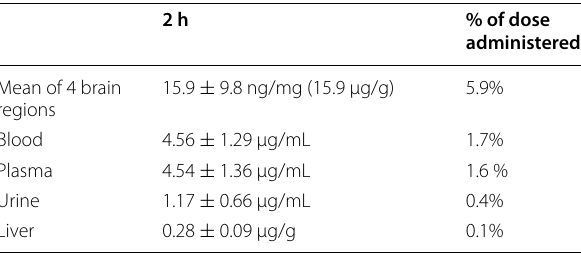
Table 1 Δ 9 THC concentration in various tissues at 2 h following i.n. instillation a